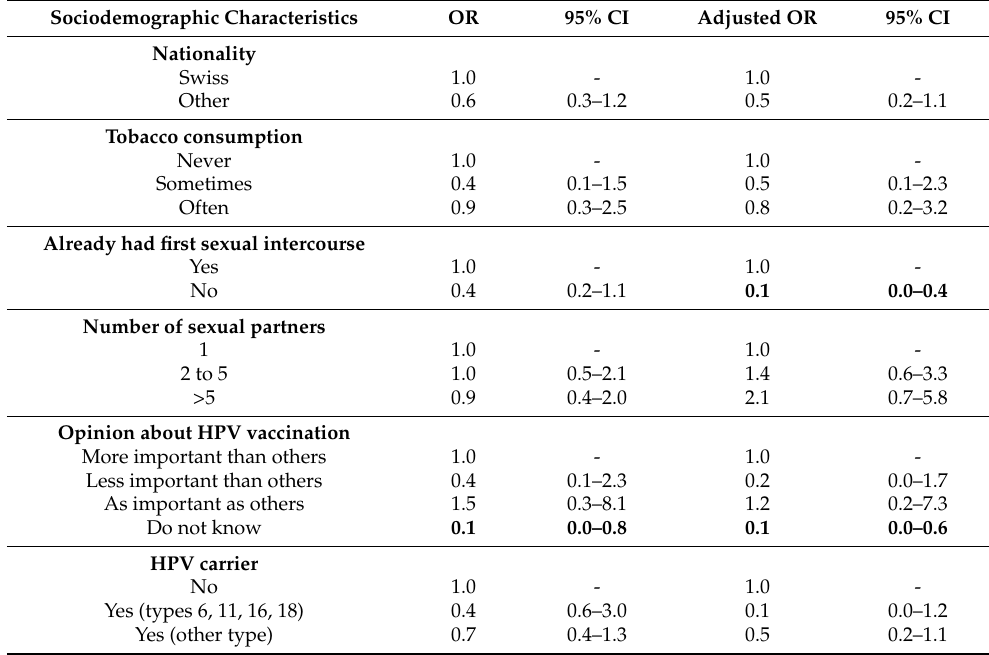
Table 2. Association between vaccination and sociodemographic characteristics: results of univariate and multivariate